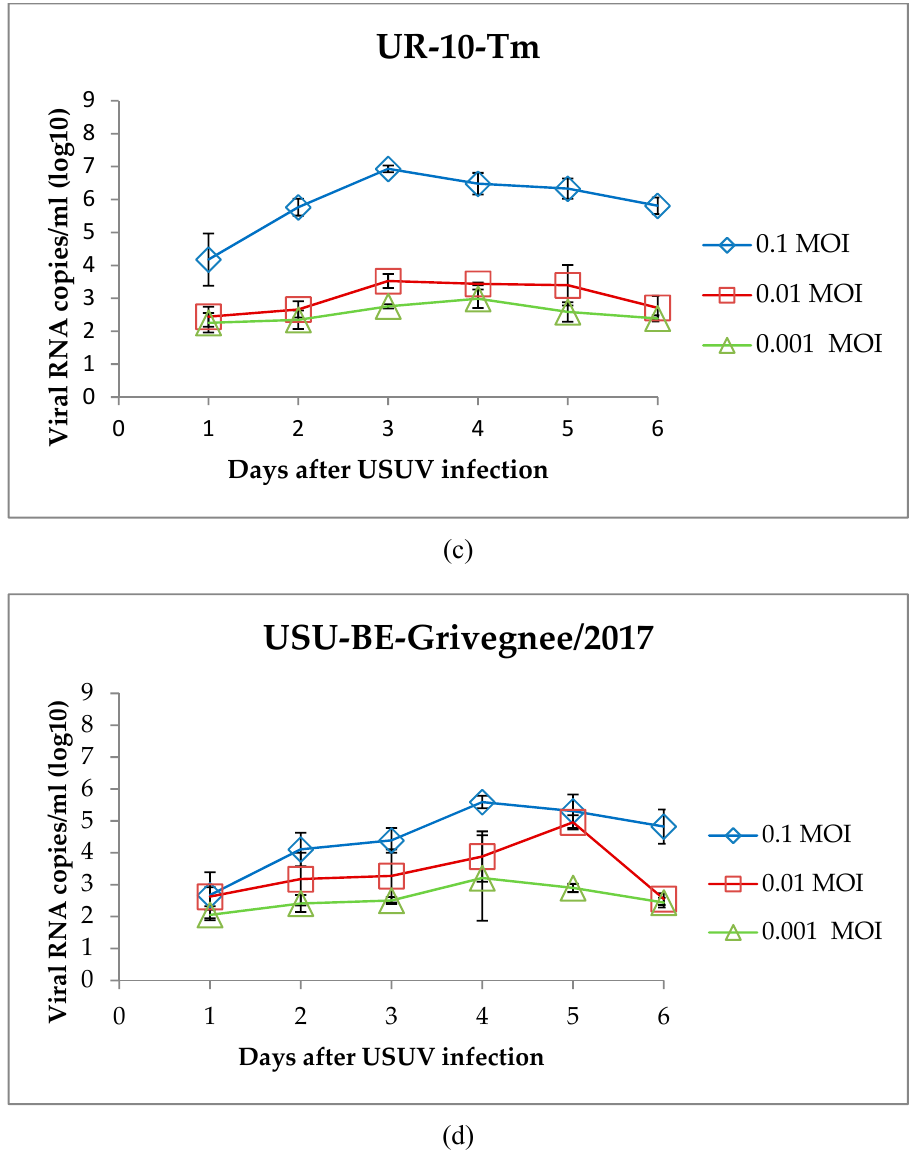
Figure 9. Viral RNA loads in the supernatants of primary cultures of chorioallantoic membrane (CAM) cells infected with different USUV strains ( a ) USU-BE-Seraing/2017 ( b ) Vienna 2001, ( c ) UR-10-Tm, and ( d ) USU-BE-Grivegnee/2017, as determined by RT-qPCR. CAM cells were infected with USUV at MOIs of 0.1, 0.01, and 0.001. Data are representative of three wells per day for each MOI, each performed in duplicate (error bars represent standard deviations).